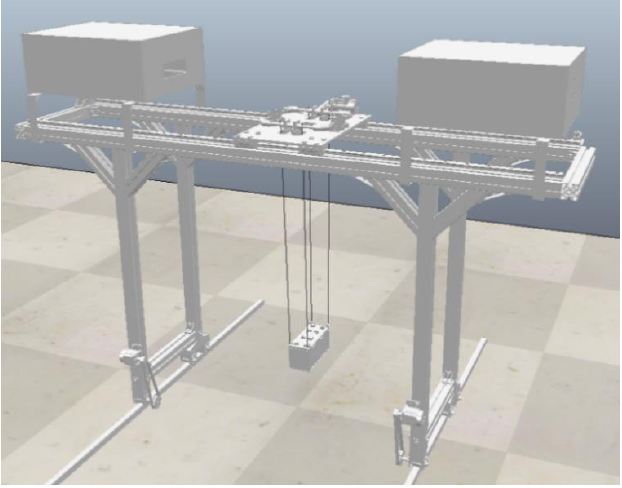
Figure 4. Three-dimensional model of the RMGC device based on CoppeliaSim (V-REP). During the virtual simulation process, there are connections between the various mechanisms of the RMGC, between the RMGC and the container, and between the contain- ers. This relationship can be described in the Python language using the script function of CoppeliaSim (V-REP). The motion of the RMGC model can be decomposed into the movement of the crane traveling mechanism, the trolley mechanism, and the lifting mecha- nism. Using the script function in CoppeliaSim (V-REP), we can also realize the data-driven virtual object and complete the mapping from the motion attributes of physical entities to virtual entities. In addition, the API function sim.checkDistance (clientID, Entity1, Entity2) in CoppeliaSim (V-REP) is used to calculate the relative distance between two objects for collision detection. When the distance is lower than a certain threshold, a warning message is sent in time to improve the security of the control